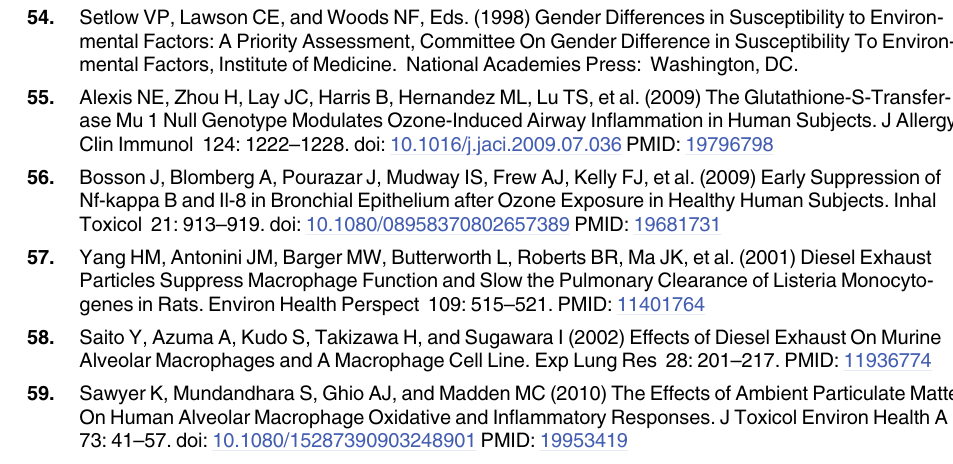
PLOS ONE | DOI:10.1371/journal.pone.0152458 April 8,